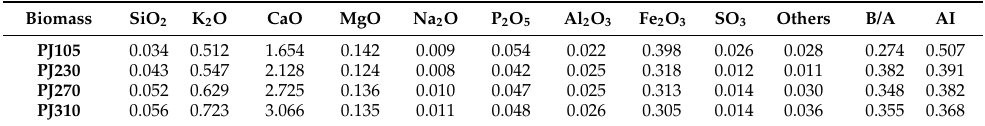
Table 3. Inorganic composition of the ash of samples (%, dry